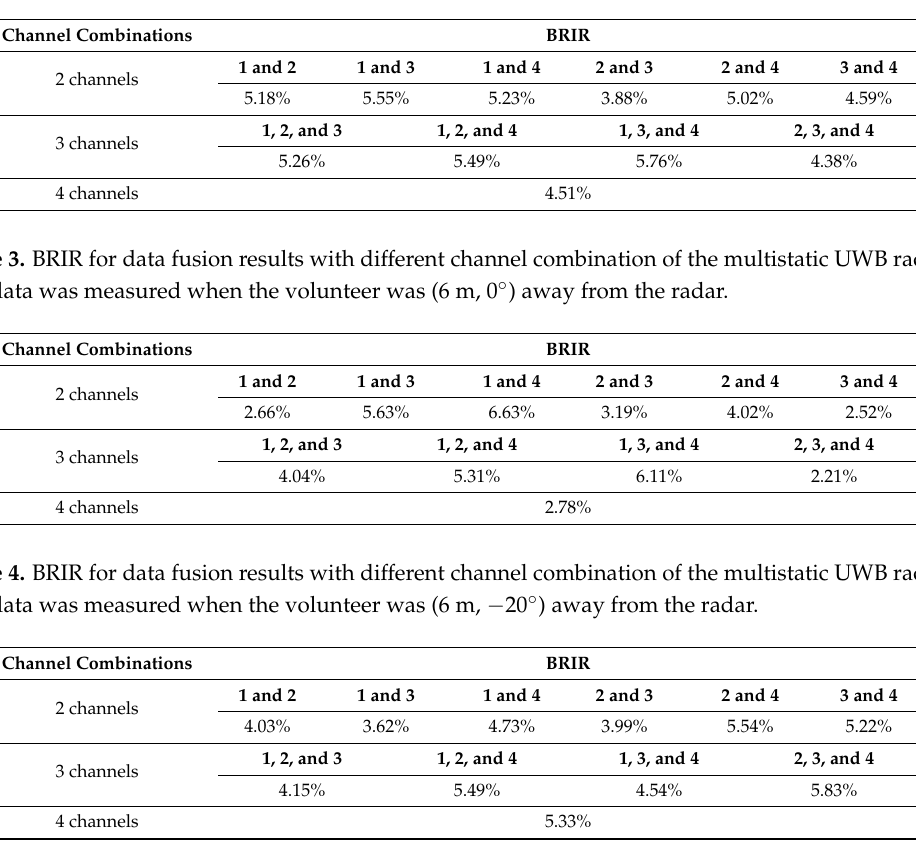
Table 2. BRIR for data fusion results with different channel combination of the multistatic UWB radar. The data was measured when the volunteer was (4 m, 0 ◦ ) away from the radar.